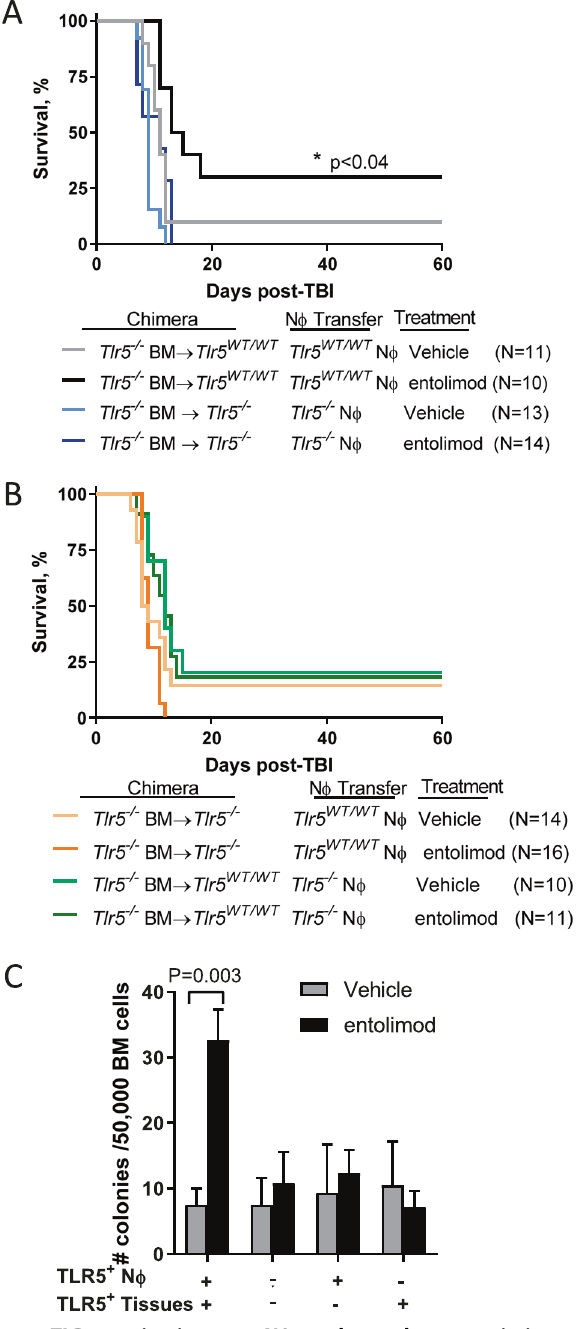
Fig. 3 TLR5 activation on N ϕ and non-hematopoietic cells cooperate to mitigate radiation damage. Tlr5 − / − bone marrow chimeric mice received an adoptive transfer of either Tlr5 WT/WT or Tlr5 − / − N ϕ (10 million /mouse) followed immediately by vehicle or entolimod 24h post-TBI. A , B Survival was measured by Kaplan – Meier curves. P - values were determined by Log-rank test; n = 10 – 16 mice/group. C Measurement of total HPPs by MethoCult in BM on day 7 post- treatment using the same experimental setup as A . Error bars represent mean±SEM; P -values were determined by Student ’ s t -test; n = 4 – 7 mice/group. In all instances, N ϕ purity was routinely